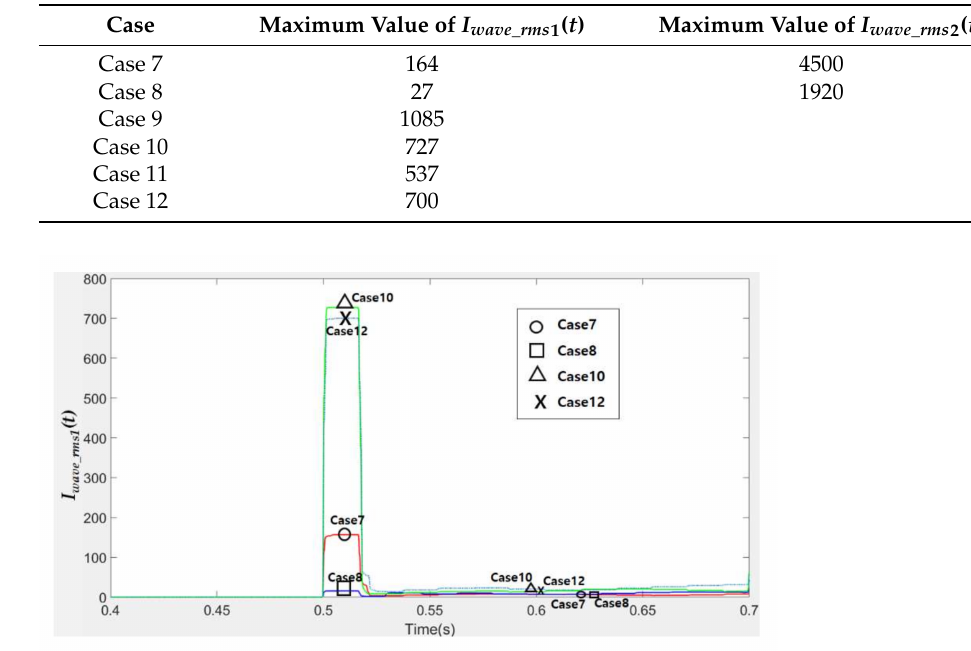
Figure 19. Comparison of I wave_rms 1 ( t ) in Cases 7, 8, 10, and 12.